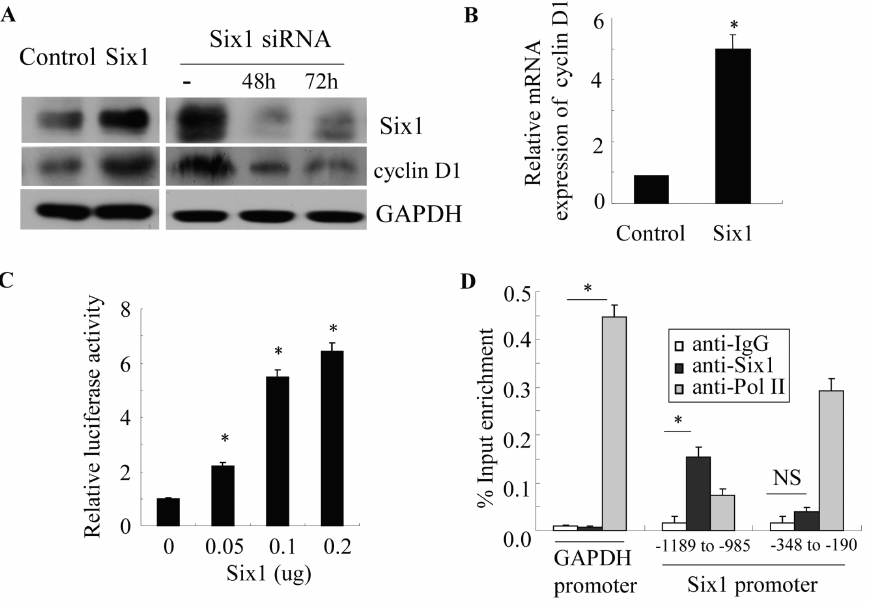
Figure 3. Six1 transcriptionally activates the gene encoding cyclin D1 in pancreatic cancer cells. A and B, The effect of Six1 on the expression of cyclin D1 protein (A) and mRNA (B) was examined in PANC-1 cells by western blot analyses. GAPDH was used as an internal control. C, cyclin D1 promoter activity was shown to be responsive to increased amounts of a Six1 expression vector, using a luciferase reporter. D, the physical interaction of Six1 to the cyclin D1 promoter in chromatin of PANC-1 cells was shown using a ChIP-qPCR assay. The recruitment of Pol II to the GAPDH proximal promoter was used as a positive control, and the negative control is normal IgG, which controls for the non-specific immunoselection of chromatin by immunoglobulins. Soluble chromatin was prepared and immunoprecipitated with the indicated antibodies. The final DNA extractions were amplified using three pairs of primers as indicated. It showed that Six1 could bind to the 2 1189 to 2 985 region of the cyclin D1 promoter but not to the irrelevant 2 348 to 2 190 region. All experiments were performed in triplicate; NS, not significant; * P ,